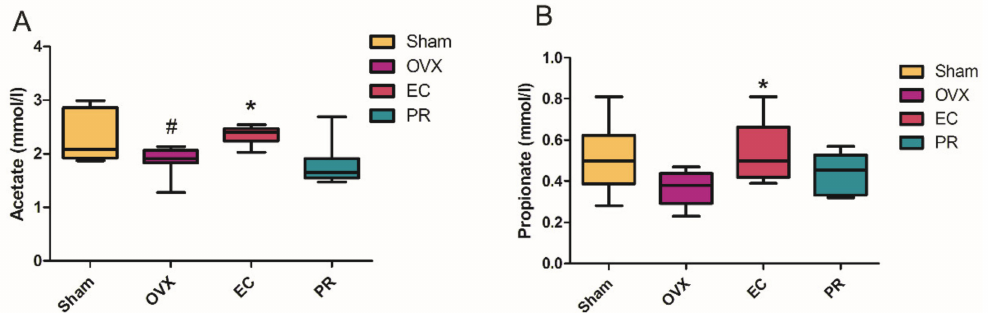
Figure 7. The effects of Erythrinae Cortex (EC) extract treatment on the serum levels of short chain fatty acids (SCFAs). ( A ) the levels of acetate; ( B ) the levels of propionate. Values represent the mean SEM. Statistical analysis was performed by one-way analysis of variance (ANOVA) followed by Tukey’s post-hoc test ( n = 10–12). # p < 0.05 vs. Sham and * p < 0.05 vs.